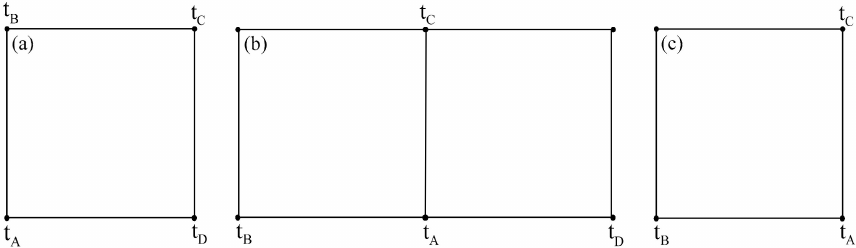
Figure 1. Sketch map of ( a , b ) the Vidale finite-difference scheme and ( c ) the improved Vidale finite- difference scheme. t c is the traveltime of point C to be solved, t a , t b and t d are the known traveltime of points A, B and D, respectively; t a is the minimal value, and h is the grid spacing.